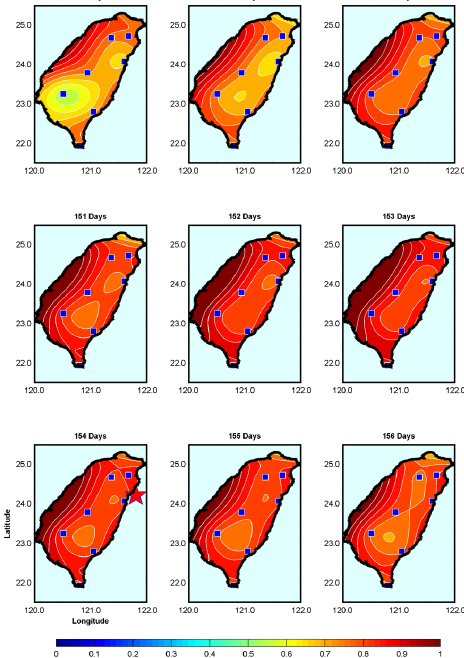
Fig. A5. A contour map of the cross correlation values from nighttime data during EQ10 (the red star).